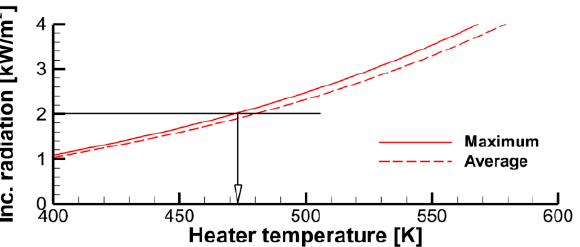
Figure 8. Maximum and surface-averaged incident radiative flux at the specimen exposed surface as a function of the heater temperature.